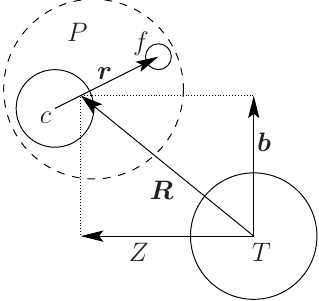
Figure 2: Jacobi set of coordinates used to describe the collision of a two-body projectile P onto a target T . The former is described as a fragment f bound to a core c separated by the internal coordinate r . The relative coordinate of the projectile centre of mass to the target R is decomposed into its longitudinal Z and transverse b